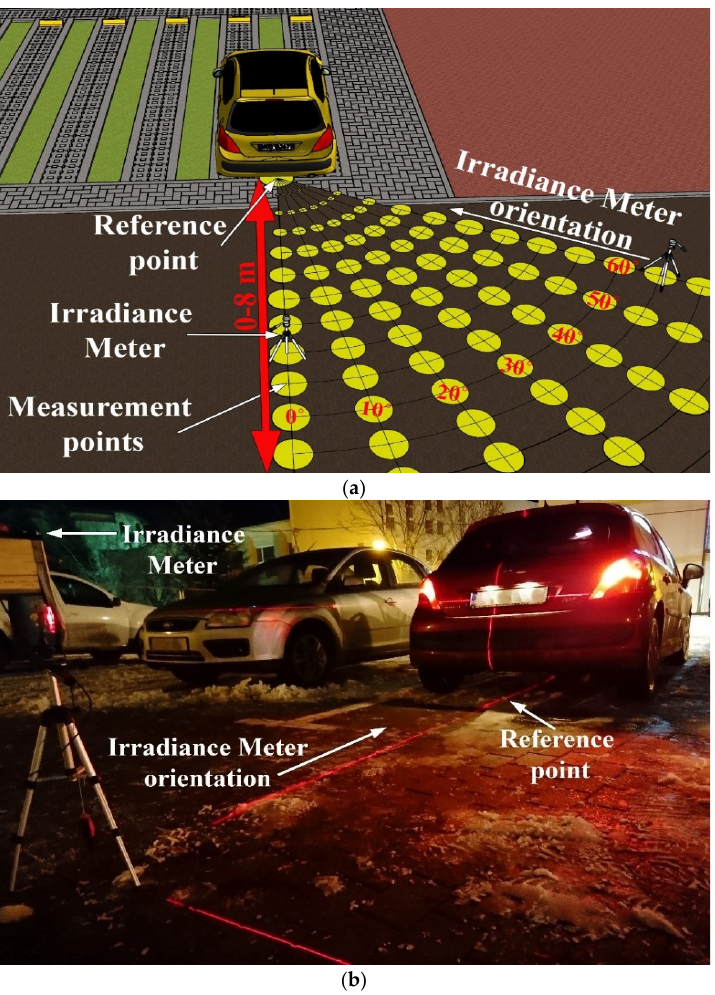
Figure 4. Vehicle light irradiance experimental measurement procedure: ( a ) envisioned testing scenario; ( b ) experimental testing setup.